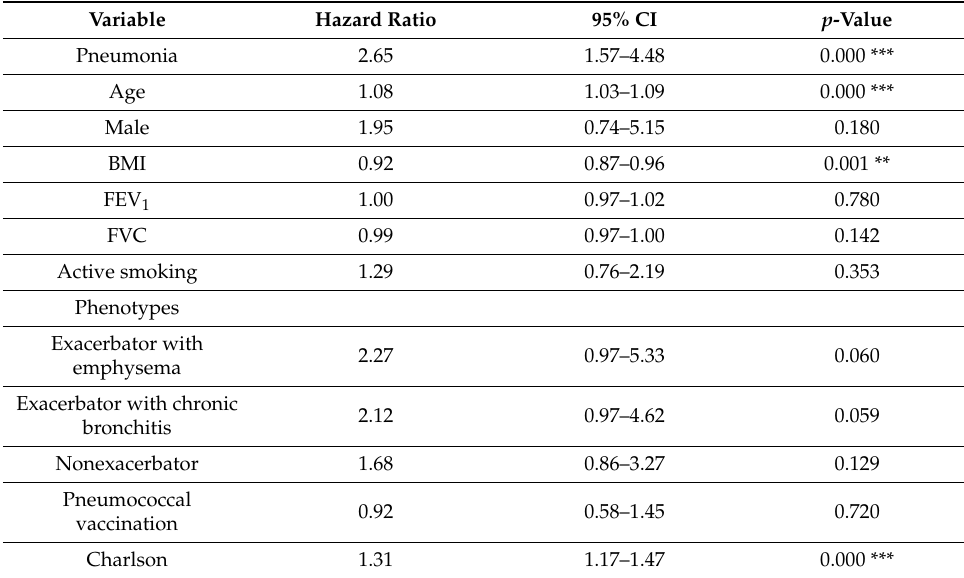
Table 4. Risk factors independently associated with